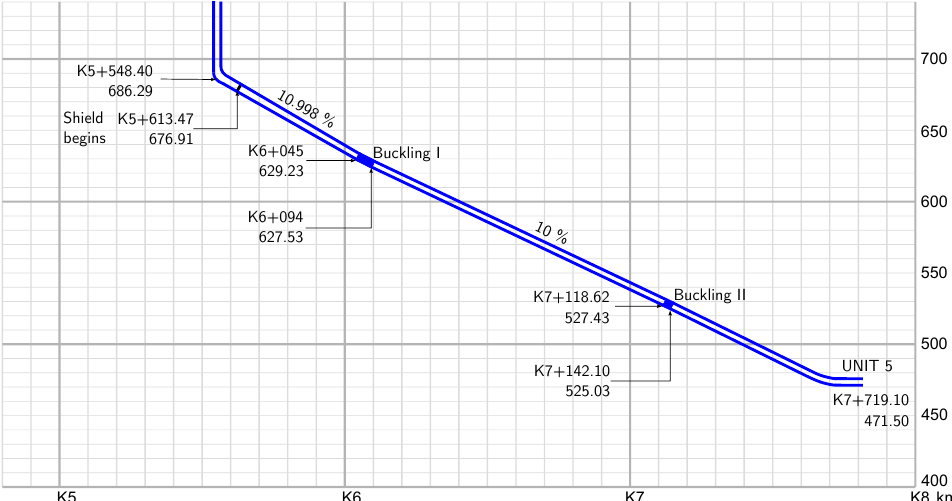
Figure 3. Chivor II shielded headrace tunnel buckling